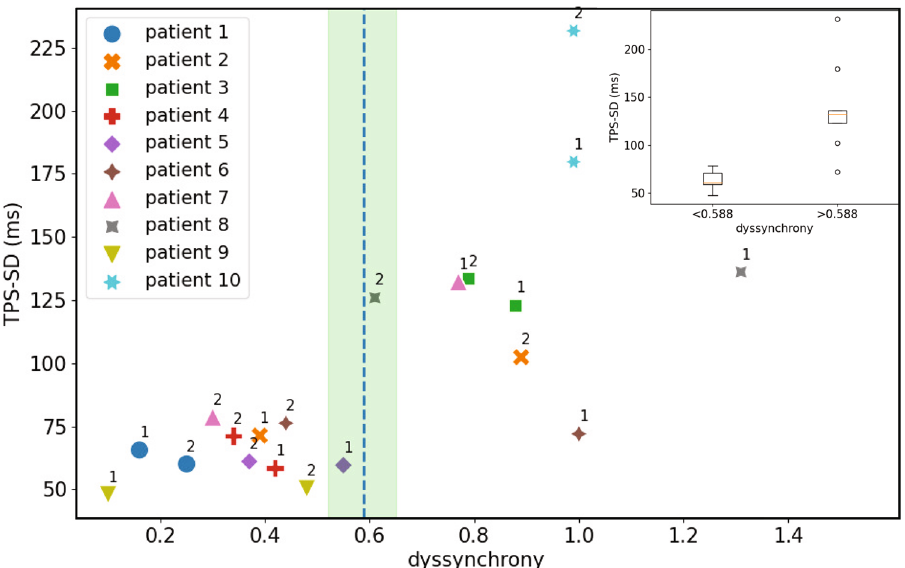
Figure 4. Simultaneous quantification of mechanical dyssynchrony and the dyssynchrony index. Standard deviation of the time to peak strain (TPS-SD) plotted against the dyssynchrony index. The marker styles represent different patients, 1 and 2 represent the ventricular stimulations denoted in Table 1. Green shaded area and blue vertical dashed line indicate, respectively, the range (0.519–0.657) and average (0.588) of the optimal cut-off values determined by using a logistic regression analysis (see the Methods section, subsection Statistical Methods and Fig. S5). Inset: Box plot showing TPS-SD for 10 patients (20 pacing configurations) grouped according to the average cut-off value for the dyssynchrony index (p = 0.00031). The figure was created using Python’s Matplotlib library (v.3.4.2.) 37